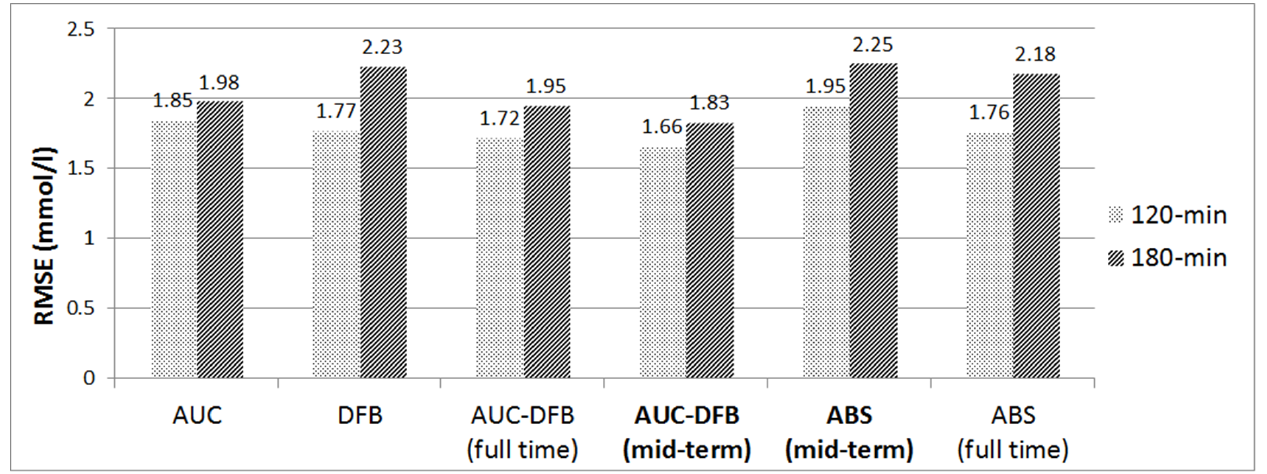
Table 10. Cross-validation results for the AUC-DFB version, all values in mmol/L. The V1 version is the model trained with the training/validation data division as described above, while the V2 and V3 versions use another third of the sam- ples for validation.